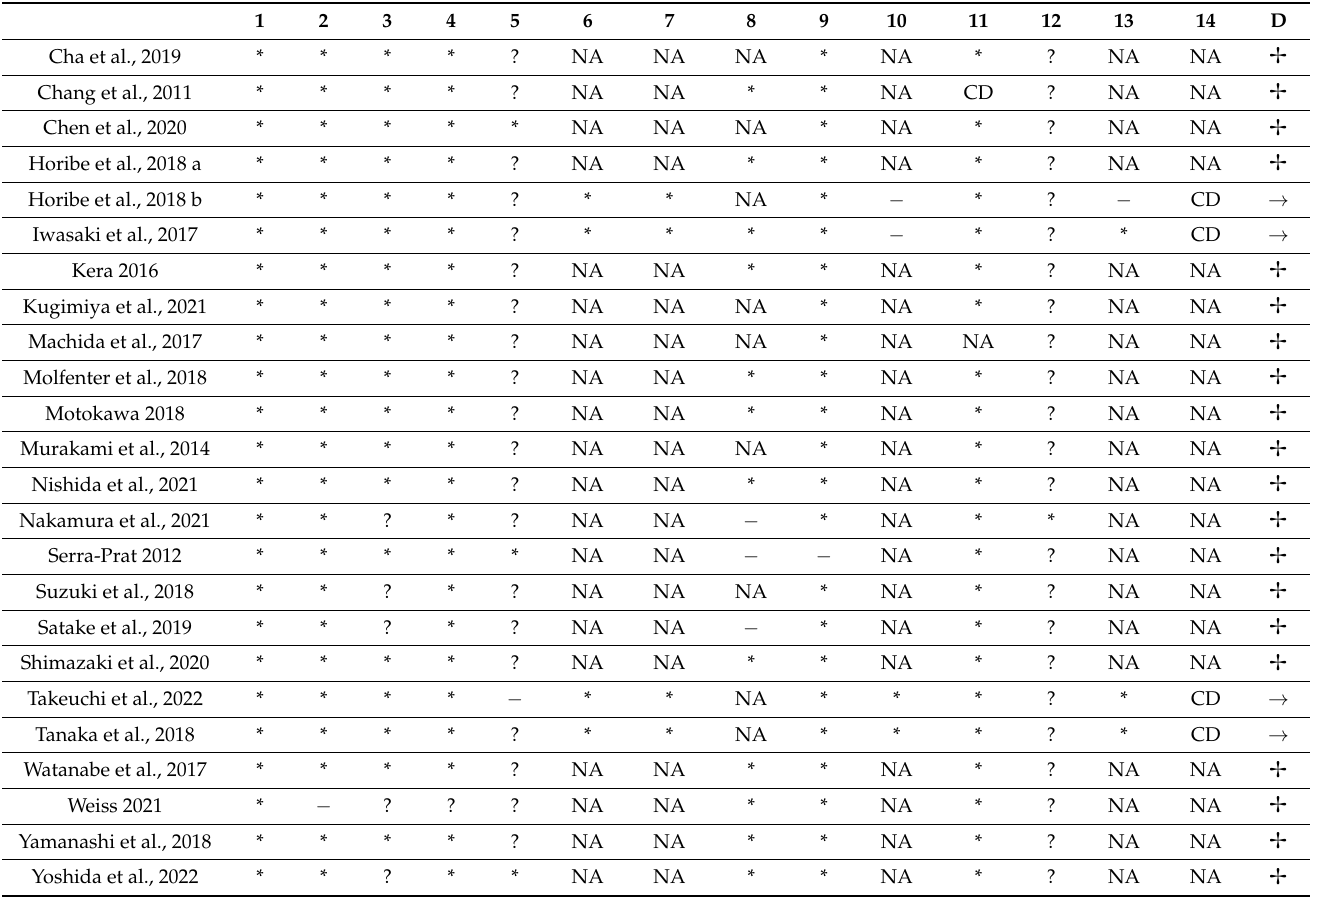
Table 4. Quality assessment for each study using the National Institutes of Health’s Quality Assess- ment Tool for Observational Cohort and Cross-Sectional Studies.